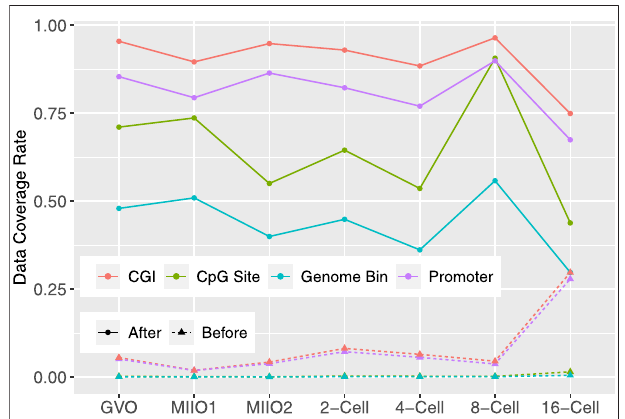
FIGURE 5 | Before and after imputation, the data coverage rate for all CpGs in the genome and three categories of genomic features: